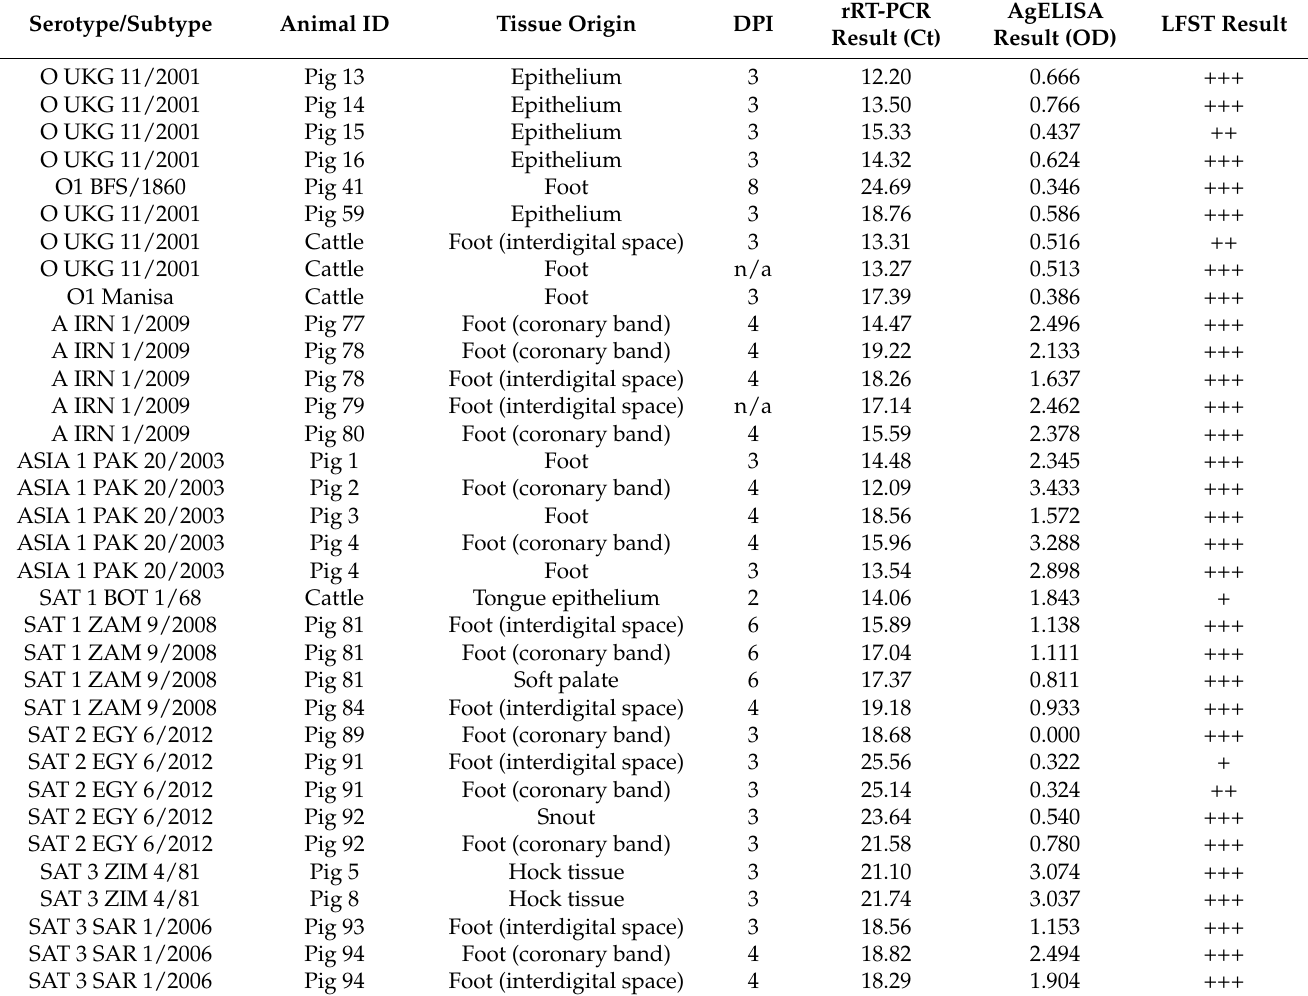
Pan-serotype FMDV lateral flow strip test (LFST) results for FMDV-positive tissue suspensions. Tissue suspensions positive for FMDV by real-time reverse transcription polymerase reaction (RRT-PCR) were each tested in